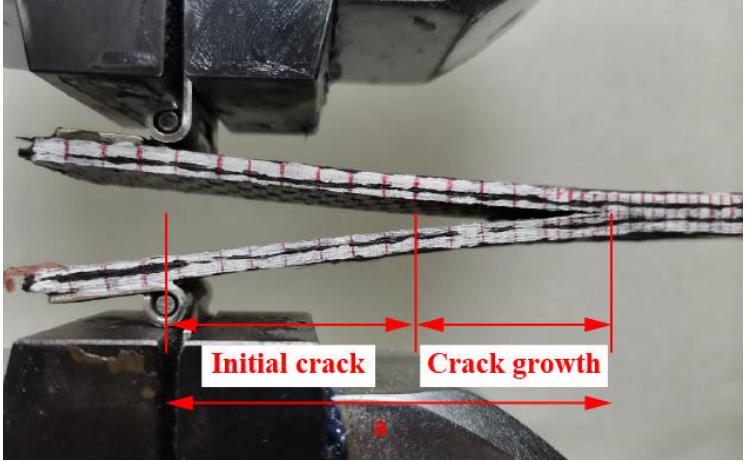
Figure 3. Illustration of the initial crack and the crack growth lengths in the DCB specimen.